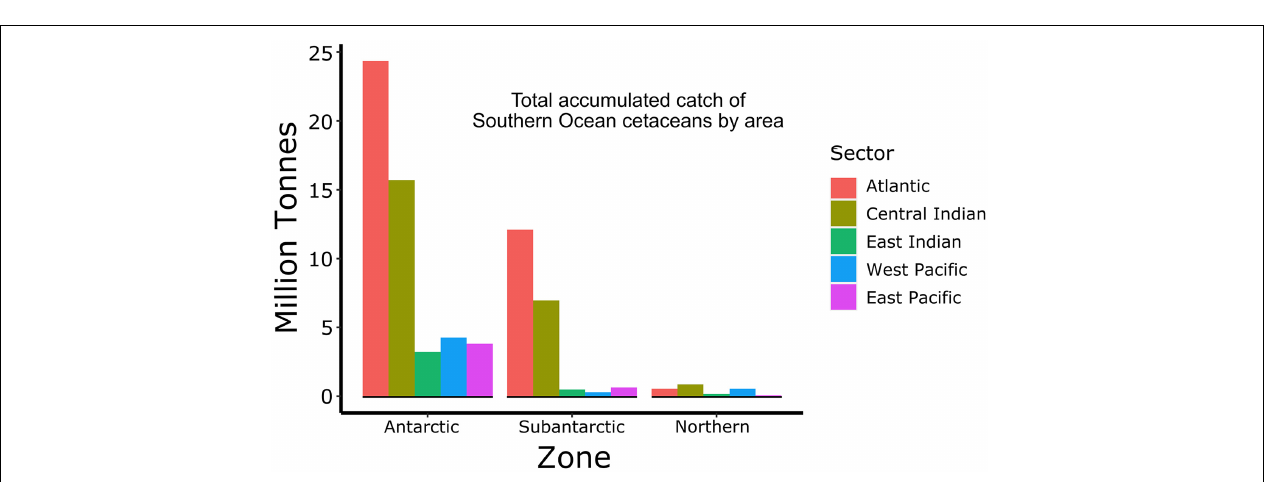
FIGURE 5 | Total accumulated catch (million tonnes) of Southern Ocean cetaceans in each sector (right legend) from each zone of MEASO areas as shown in Figure 2 . Data from IWC Catch Records.